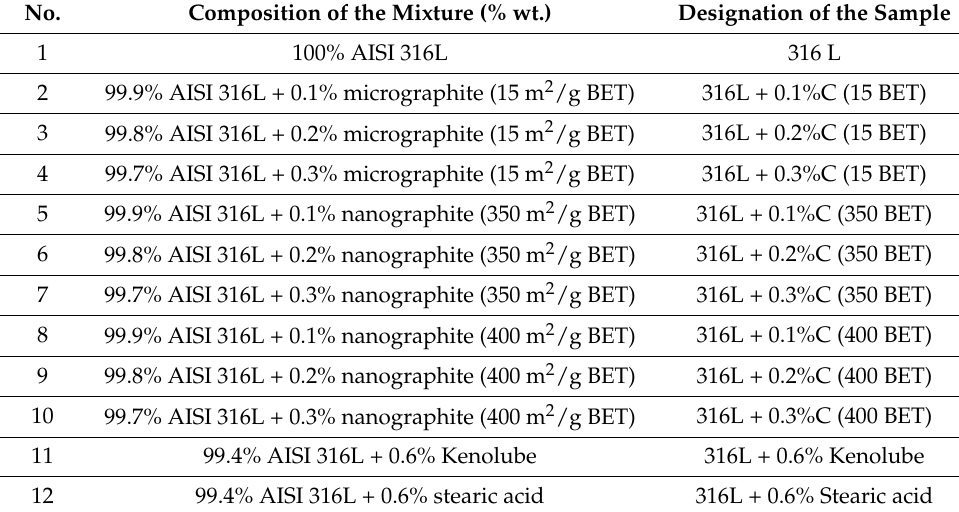
Table 3. The composition of the individual tested mixtures and the adopted designation. No. Composition of the Mixture (%